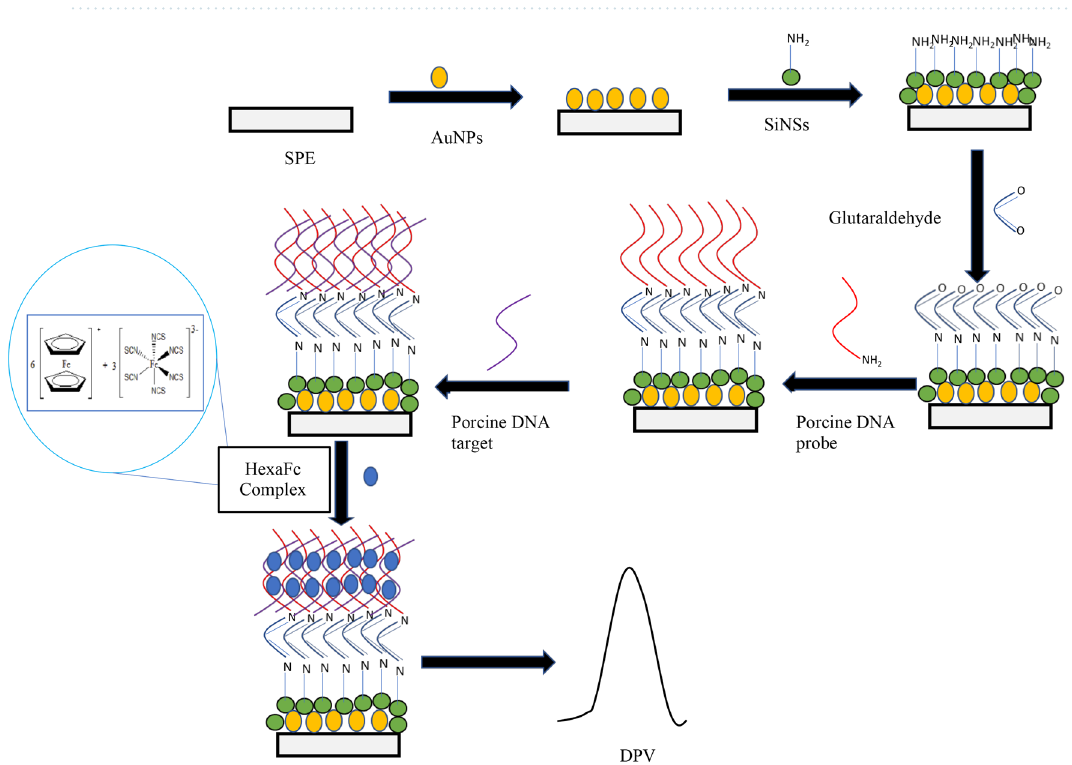
Figure 2. Fabrication of porcine DNA biosensor using HexaFc as DNA hybridisation